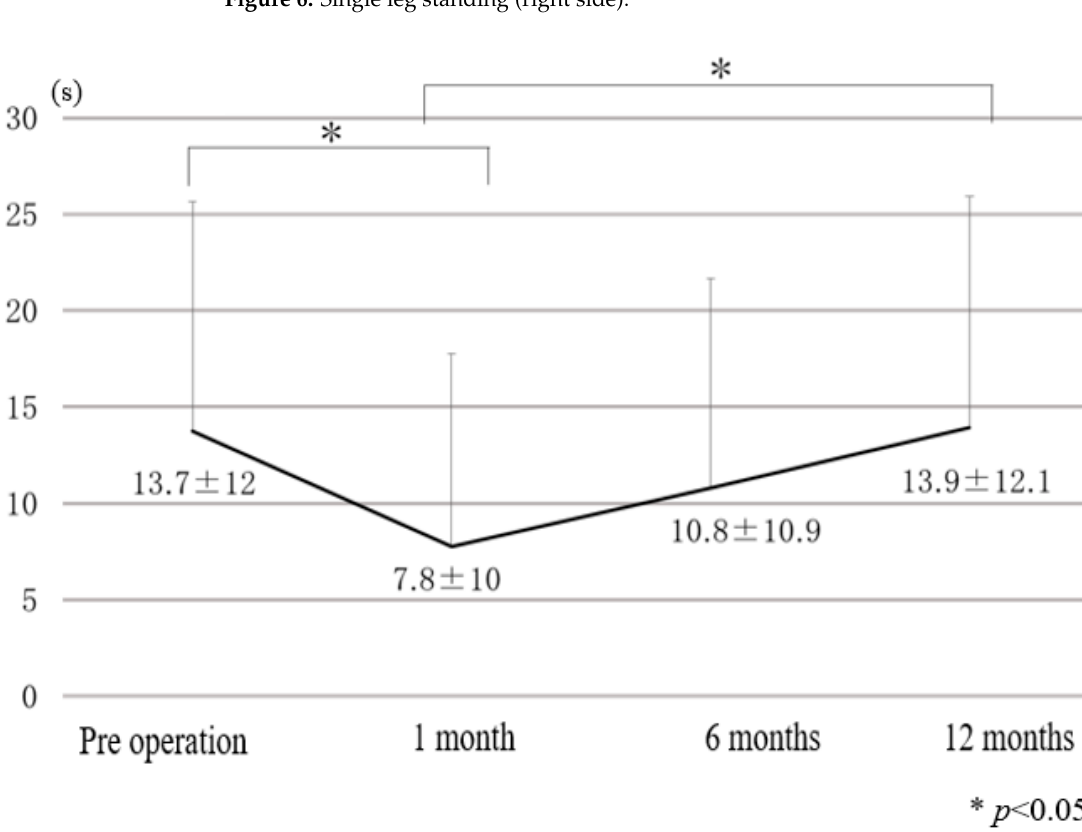
Figure 6. Single leg standing (right side).